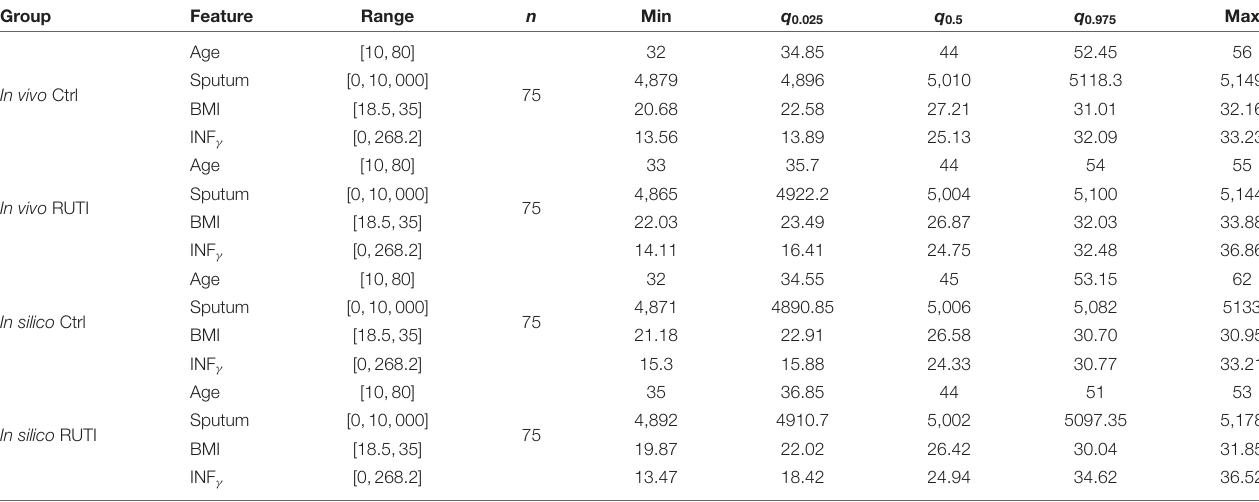
TABLE 1 | Key patient features.